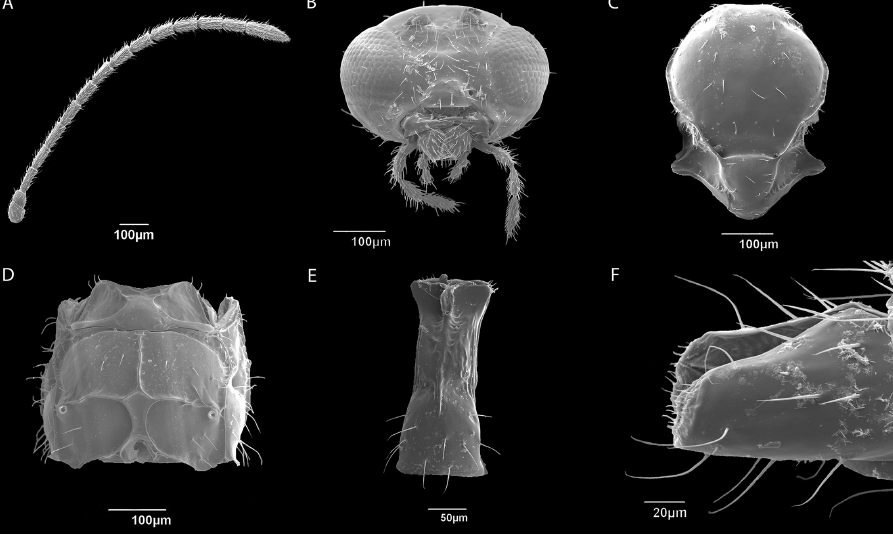
Figure 1. Aphidius ericaphidis female: A antenna B head C mesonotum – dorsal aspect D propodeum – dorsal aspect E petiole – dorsal aspect F ovipositor – lateral